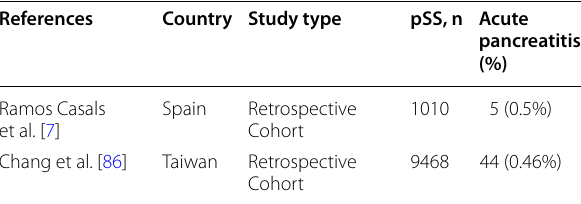
Table 5 Acute pancreatitis prevalence in Sjögren